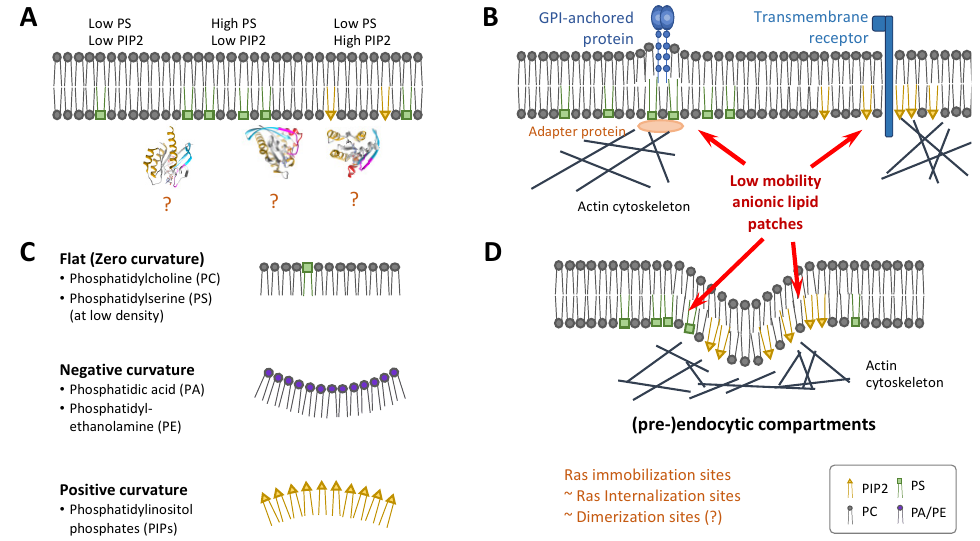
Figure 6. Membrane heterogeneity and topography in Ras dimerization. ( A ) Heterogeneous distribution of anionic lipids such as PS and PIP2 yields membrane regions with lipid compositions favoring some but not other Ras conformations, which could directly impact Ras dimerization. ( B ) Ex- ample mechanisms that couple actin polymerization with the local enrichment of PS (left) or PIP2 (right), yielding membrane patches of anionic lipids with relatively low mobility, which could entrap membrane proteins such as Ras. ( C ) Local enrichment of lipids could induce membrane curvature, potentially impacting Ras dimerization. ( D ) Endocytic and pre-endocytic compartments are examples of enriched anionic lipids coupled with actin polymerization and membrane curvature. There is evidence that Ras immobilization occurs in the same membrane nanodomains that internalize Ras, making some (pre-)endocytic compartments candidate sites for Ras dimerization and